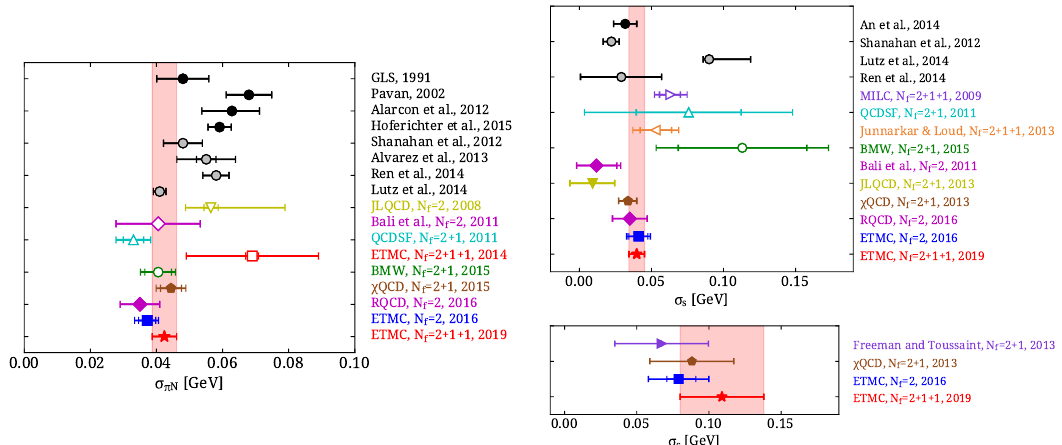
-term (upper right) and the s